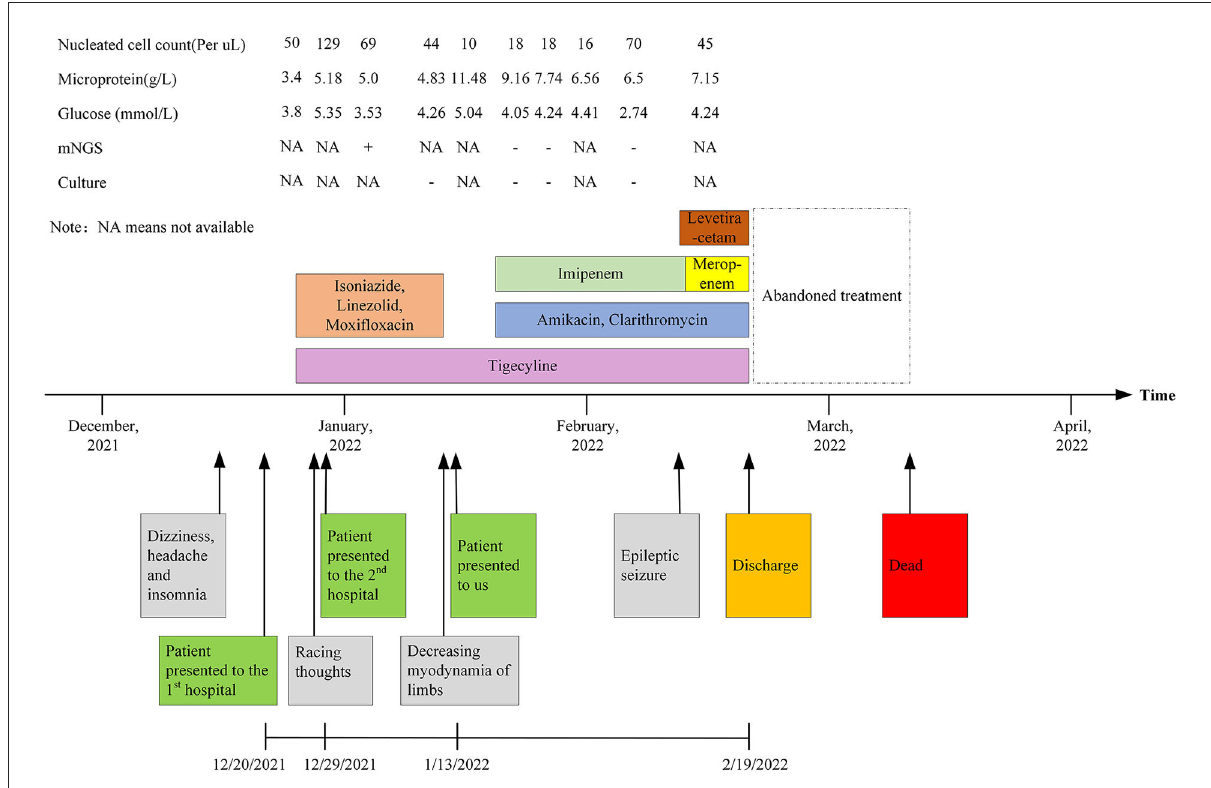
FIGURE4 Clinical course, CSF findings, and antibiotic regimens for our